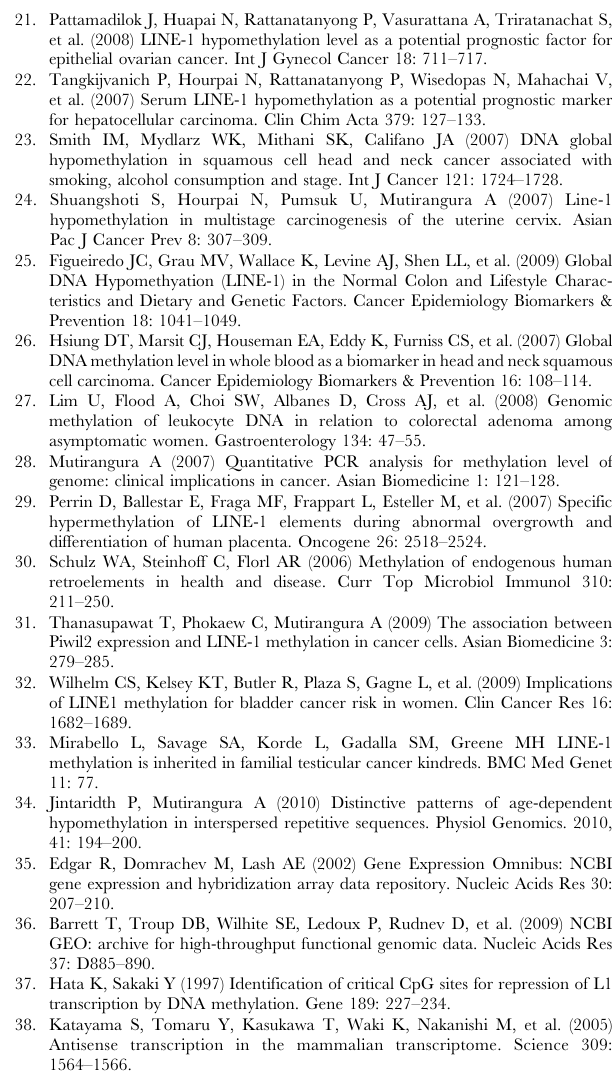
Table S6 List of GSE records and GSM samples, type of t-test, and 2 6 2 contingency tables of chi-square tests for the analysis of up-regulation in genes possessing internal L1s. The data were displayed for expression in demethylated lung cancer cells (Table (Table S6.5), AGO3sh (Table S6.6), and AGO4sh (Table S6.7).